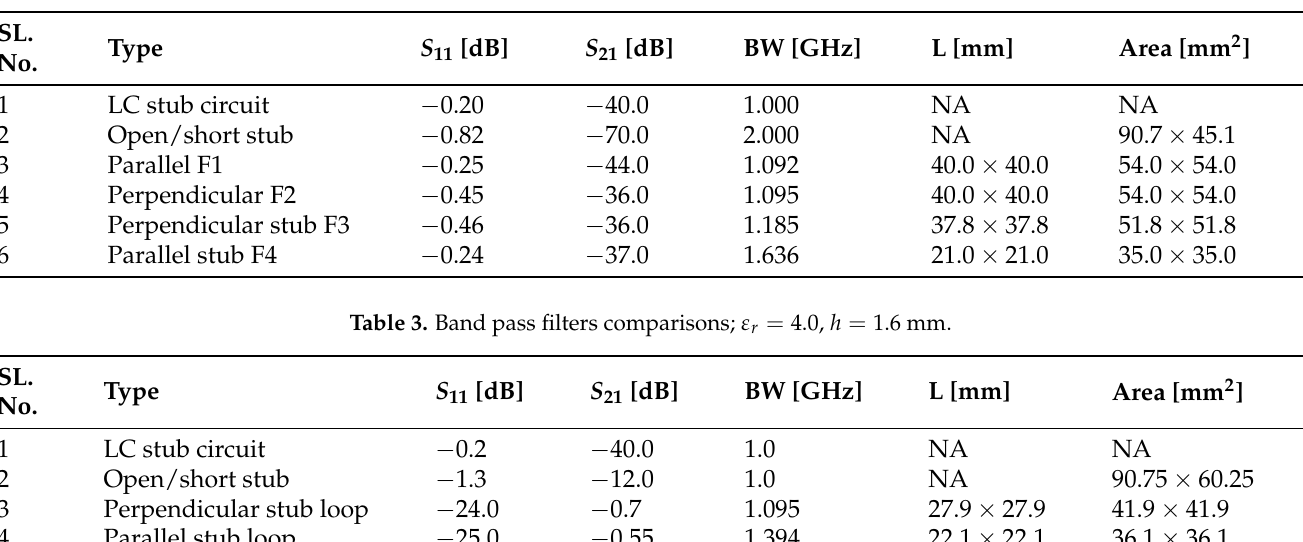
Table 2. Band stop filters comparisons; ε r = 4.0, h = 1.6 mm.